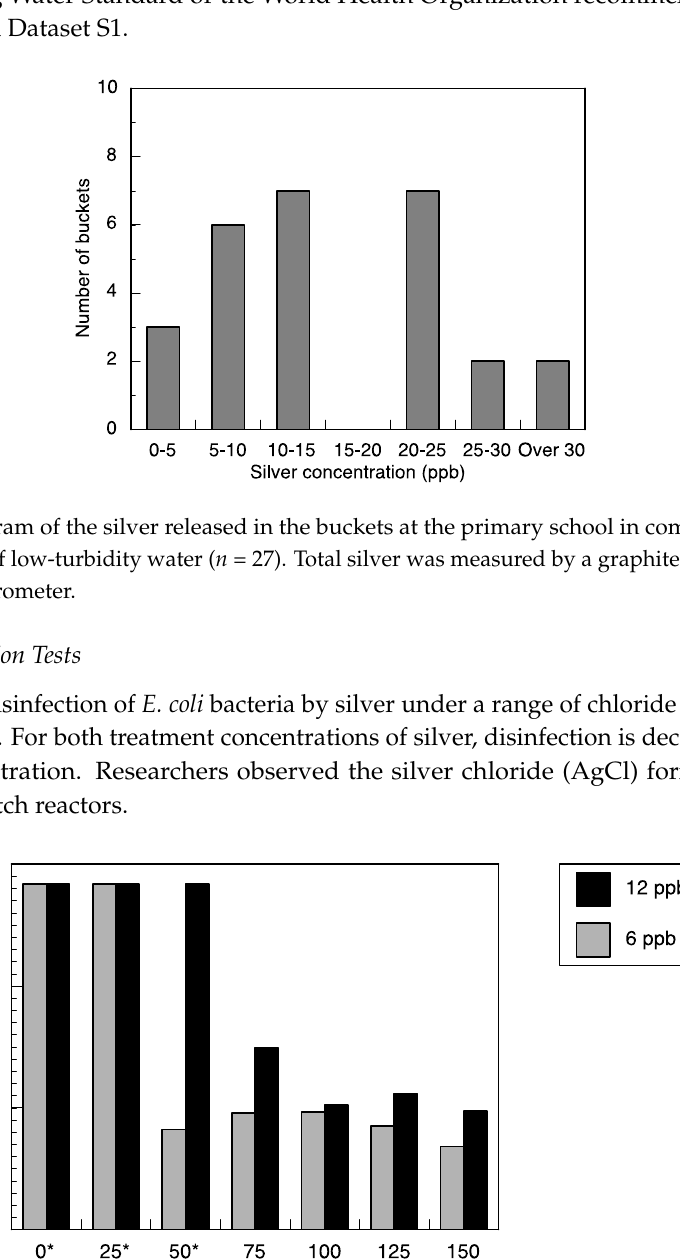
Figure 7. Reduction of E. coli bacteria by two concentrations of silver ions under a range of chloride ion concentrations (zero to 150 mg/L). The batch reactors with a chloride concentration marked (*) may have higher disinfection as the treated samples did not detect any bacteria and the